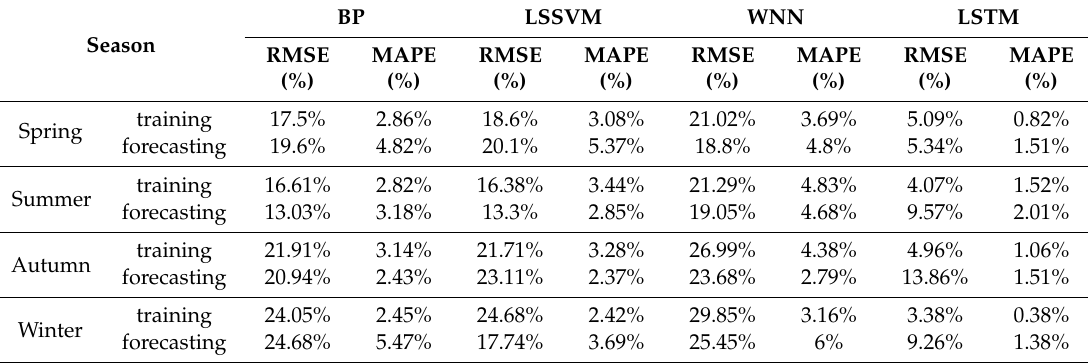
Figure 9. Comparison of training results of different algorithms and actual values in summer (from 1 June to 31 July 2017). Table 4. RMSE and MAPE of training and forecasting in every season